Question: Provide a one-line summary of what is displayed.
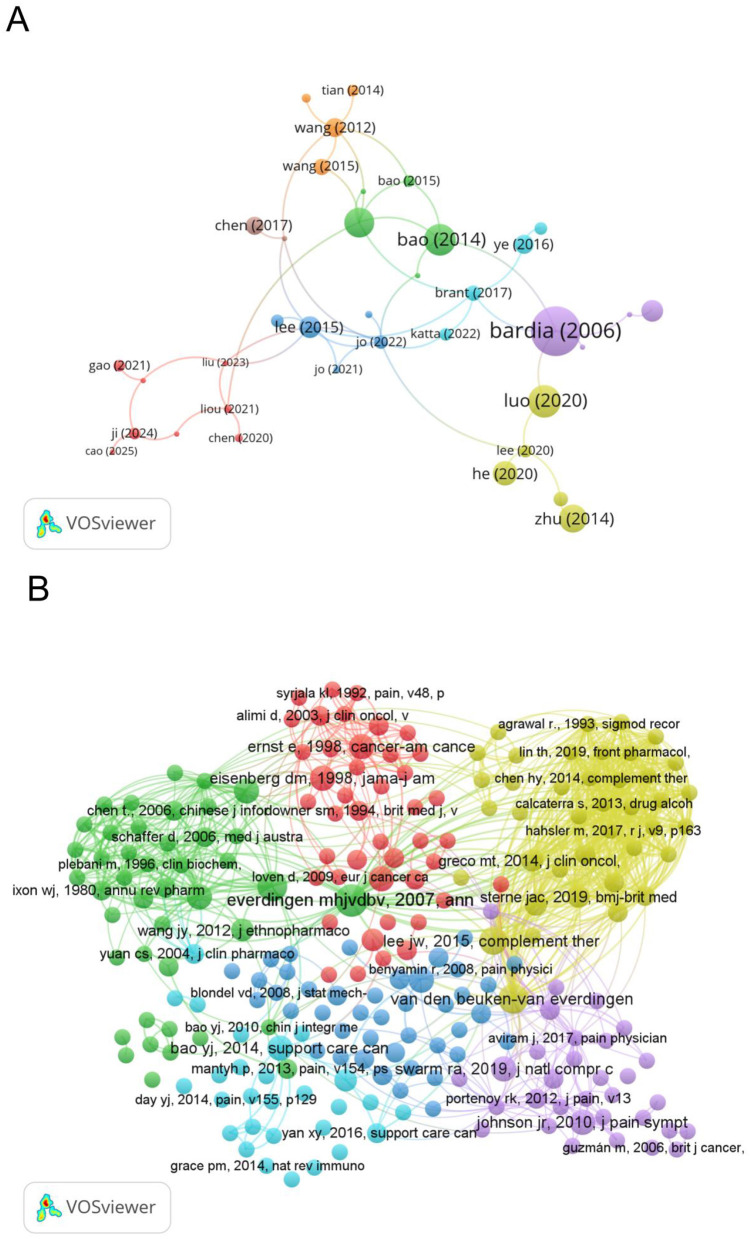
Answer: Citation and co-citation analysis of references. (A) Network visualization of reference citation. Each node represents a cited publication, with node size reflecting citation frequency. Links indicate citation relationships among publications. (B) Network visualization of co-cited references. Each node represents a co-cited reference, and links indicate co-citation relationships. Different colors represent clusters of references that constitute major knowledge domains within the field.